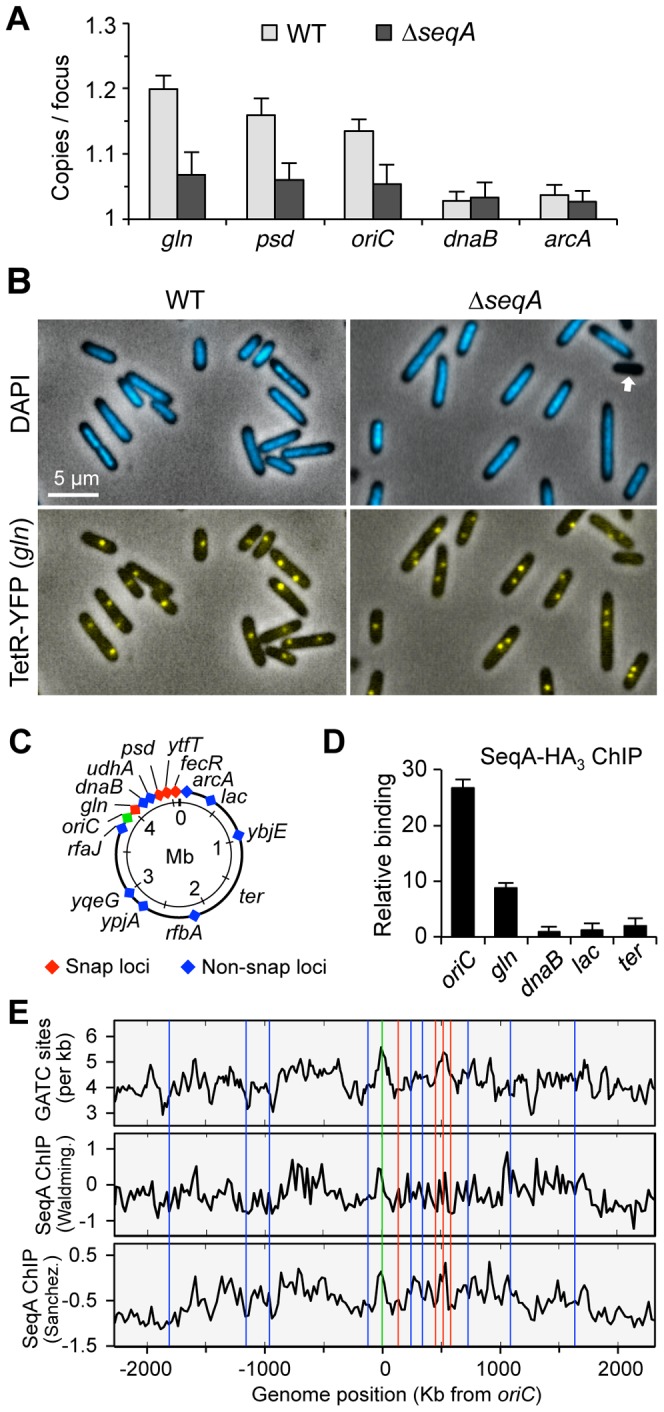
SeqA is responsible for delayed separation at late-splitting loci.(A) Loss of SeqA reduces cohesion at snaps and oriC, but not at non-snap loci dnaB and arcA. WT and ΔseqA strains bearing tetO arrays at each of the five loci shown were grown in minimal alanine media and assayed for cohesion as described in Figure 1 (3 independent experiments ±1 SD). (B) Representative micrographs of wildtype and ΔseqA cells showing nucleoids (DAPI) and gln TetR-YFP foci. ΔseqA cells exhibit ∼2% anucleate cells (arrow). (C) E. coli chromosome map with cohesion-characterized loci [6]. Snap loci (red) and oriC (green) have prolonged cohesion periods (19–30 min); non-snap loci (blue) have short cohesion periods (7–10 min). (D) Sites with prolonged cohesion bind more SeqA. SeqA binding levels at 5 loci shown were determined by ChIP-qPCR. Relative binding (2−ΔΔCt) indicates SeqA binding relative to the poorest binding sequence, dnaB. (E) Genomic analysis of GATC frequency, SeqA binding, and cohesion. GATC per kb (top panel), and SeqA binding from two SeqA ChIP-chip studies; Waldminghaus et. al. [31] (middle panel) and Sanchez-Romero et. al. [32] (lower panel), 40-kb moving average of SeqA binding is shown (log2 ratio of IP to input fluorescence). Positions of cohesion-characterized loci are shown as colored vertical lines.